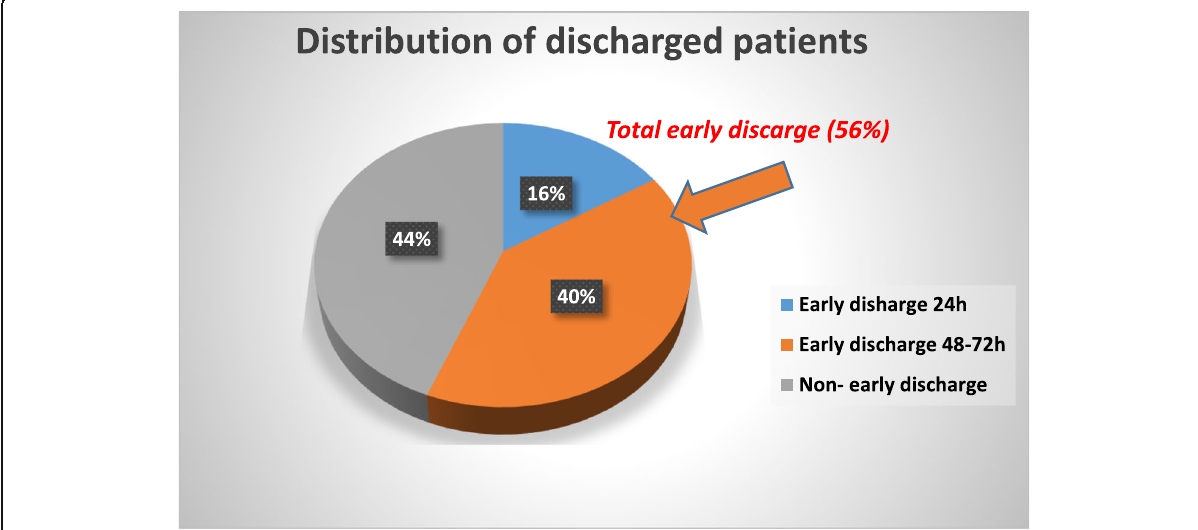
Fig. 1 Distribution of the timing of discharge of the whole population